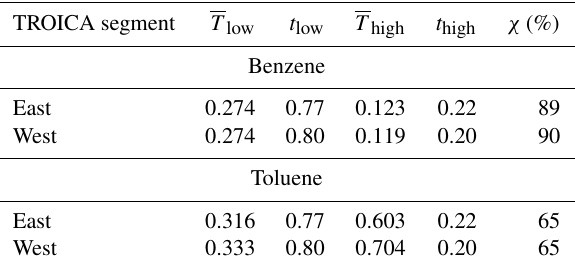
Table 3. T / B ratio for moderately to strongly polluted air (NO x >2ppb). Region